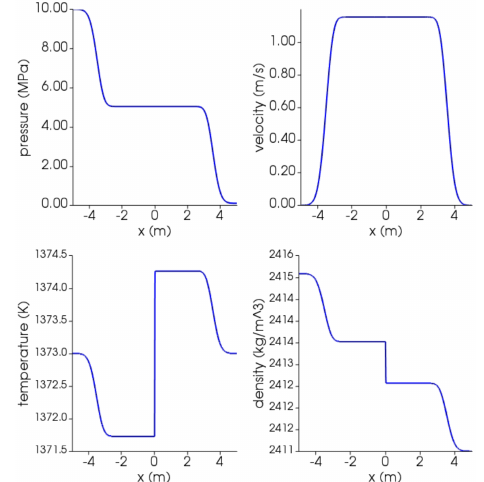
Figure C3. Results at time t = 0 . 002s for single-phase shock tube with basaltic melt using Lange–Carmichael EOS. At time 0, the interface dividing the high-pressure (left, l) from low-pressure (right, r) zone is placed at 0. Initial conditions: P l = 10MPa, P r = 0 . 1MPa; T l = T r = 1373K; gas volume fraction α l = α r = 0; U l = U r = 0. Isobaric heat capacity is C P = 1600Jkg − 1 K − 1 (Lesher and Spera, 2015). Thermal conductivity is 1 . 5WK − 1 m − 1 (Lesher and Spera, 2015).